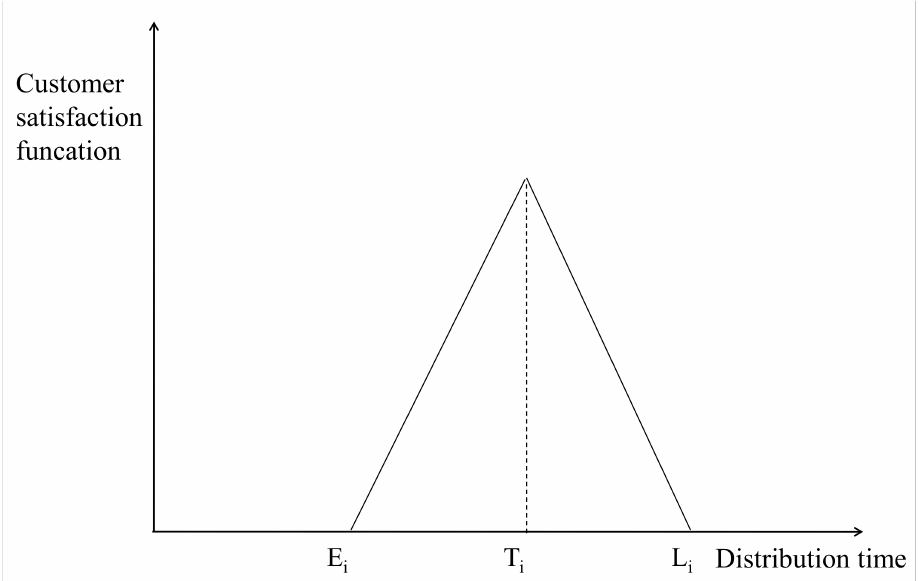
Figure 7. Customer satisfaction function graph